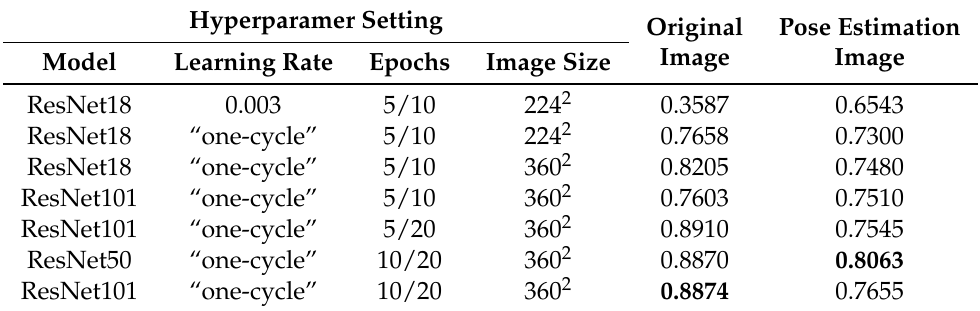
Table 5. Ablation studies on hyperparameter setting. F1 score of both models trained on original image and pose estimation image are recorded accordingly. Best results are in